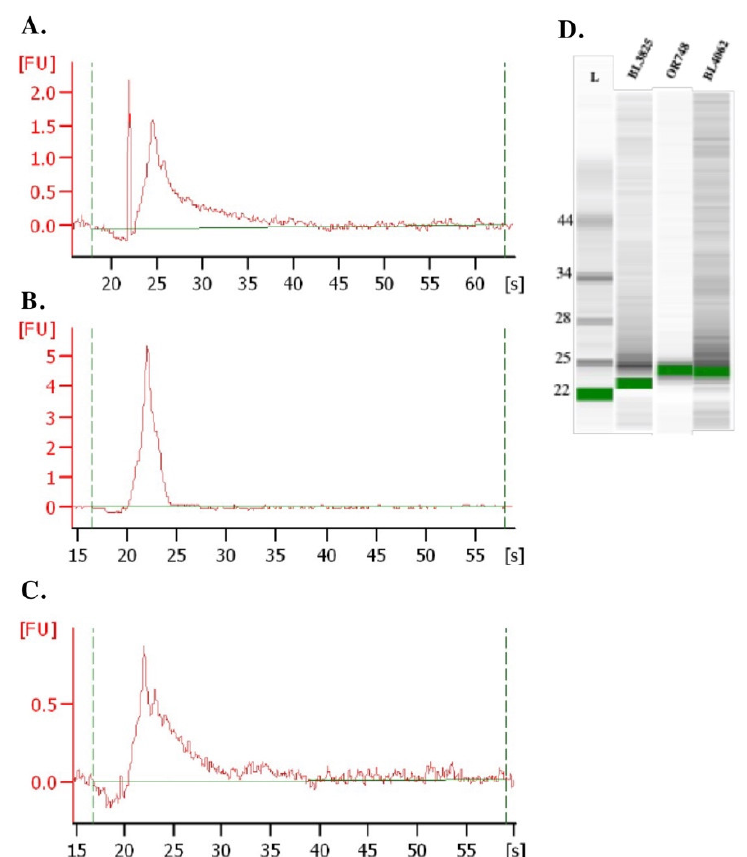
Figure 2. Size distribution of exosomal RNAs. Panels ( A – C ) show fluorograms of exosomal RNAs determined by the Agilent RNA Pico Chip. Panel ( A ) shows fluorogram of exosomal RNA from leghorn VEX (Bird tag# BL3825), leghorn TEX (Bird tag# OR748) ( B ), and broiler TEX (Bird tag# BL4062) ( C ). Panel ( D ) shows RNA chip analyses of purified exosomal RNAs.